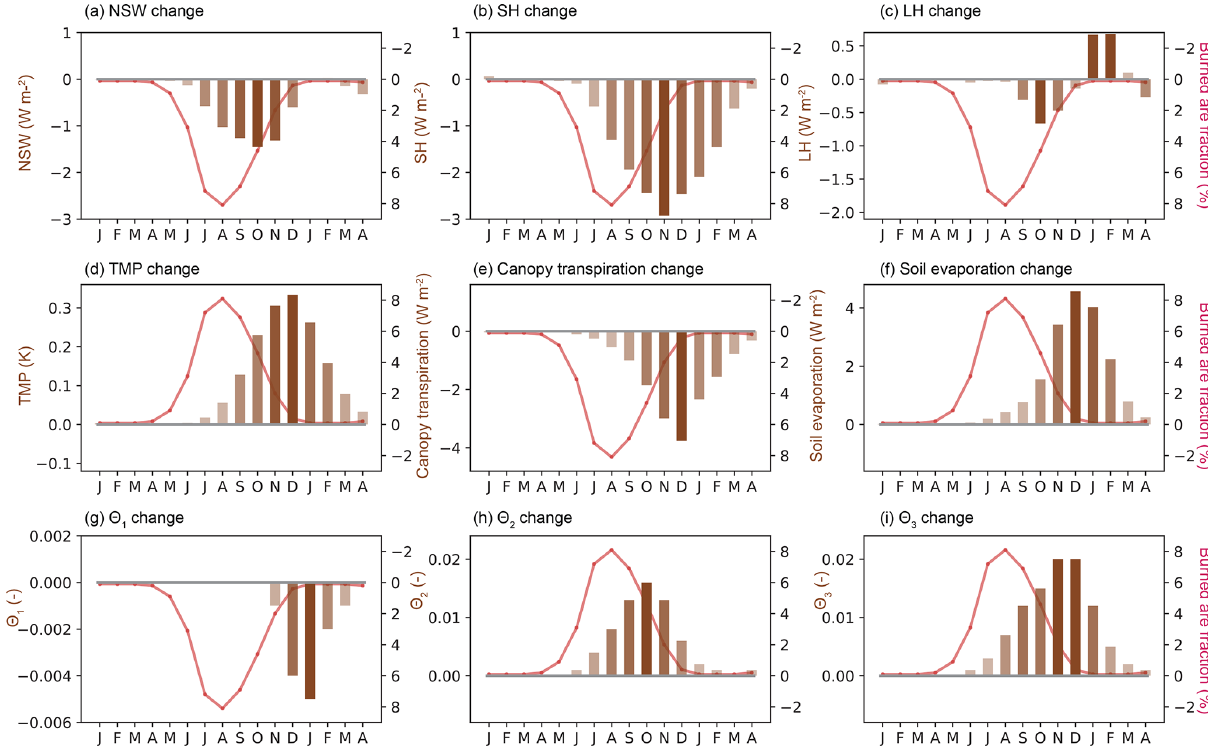
Figure 10. 2000–2013 monthly fire effects on (a) NSW (Wm − 2 ) , (b) SH (Wm − 2 ) , (c) LH (Wm − 2 ) , (d) TMP (K), (e) canopy transpiration (Wm − 2 ) , (f) soil evaporation (Wm − 2 ) , (g) θ 1 , (h) θ 2 , and (i) θ 3 with burned area fraction (%) overlaid. The y axes of burned fraction in panels (a) – (c) , (e) , and (g) are